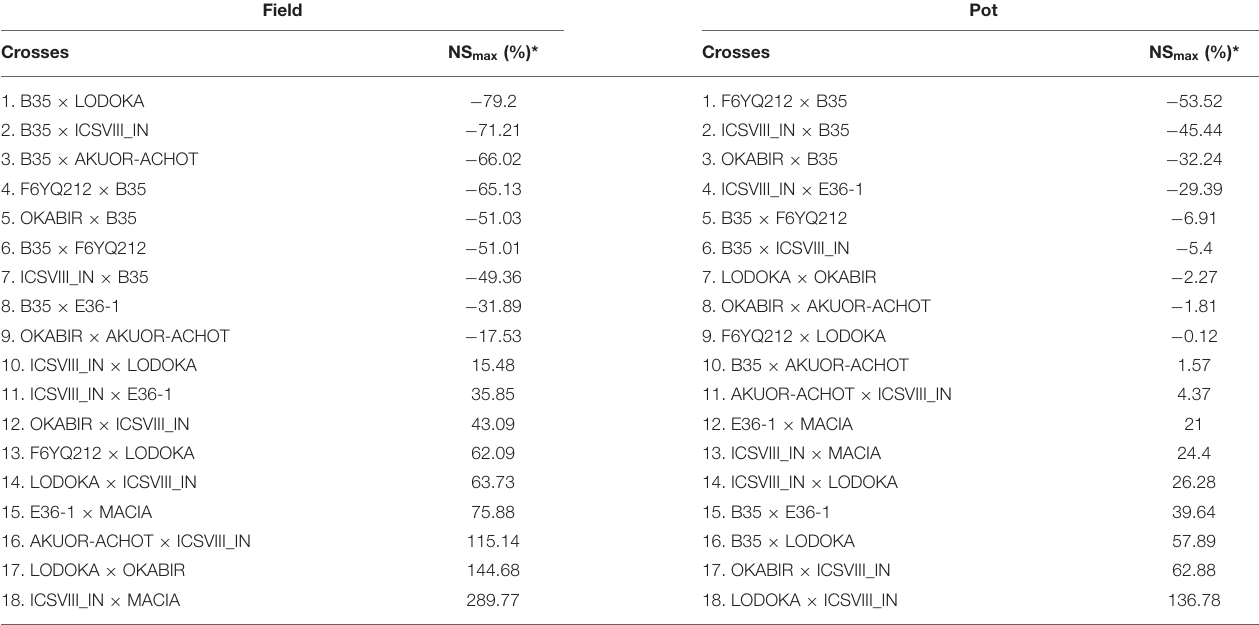
TABLE 6 | Proportion of residual heterosis at F 4 for maximum above-ground Striga (NS max ) for the pot and field trials. Field